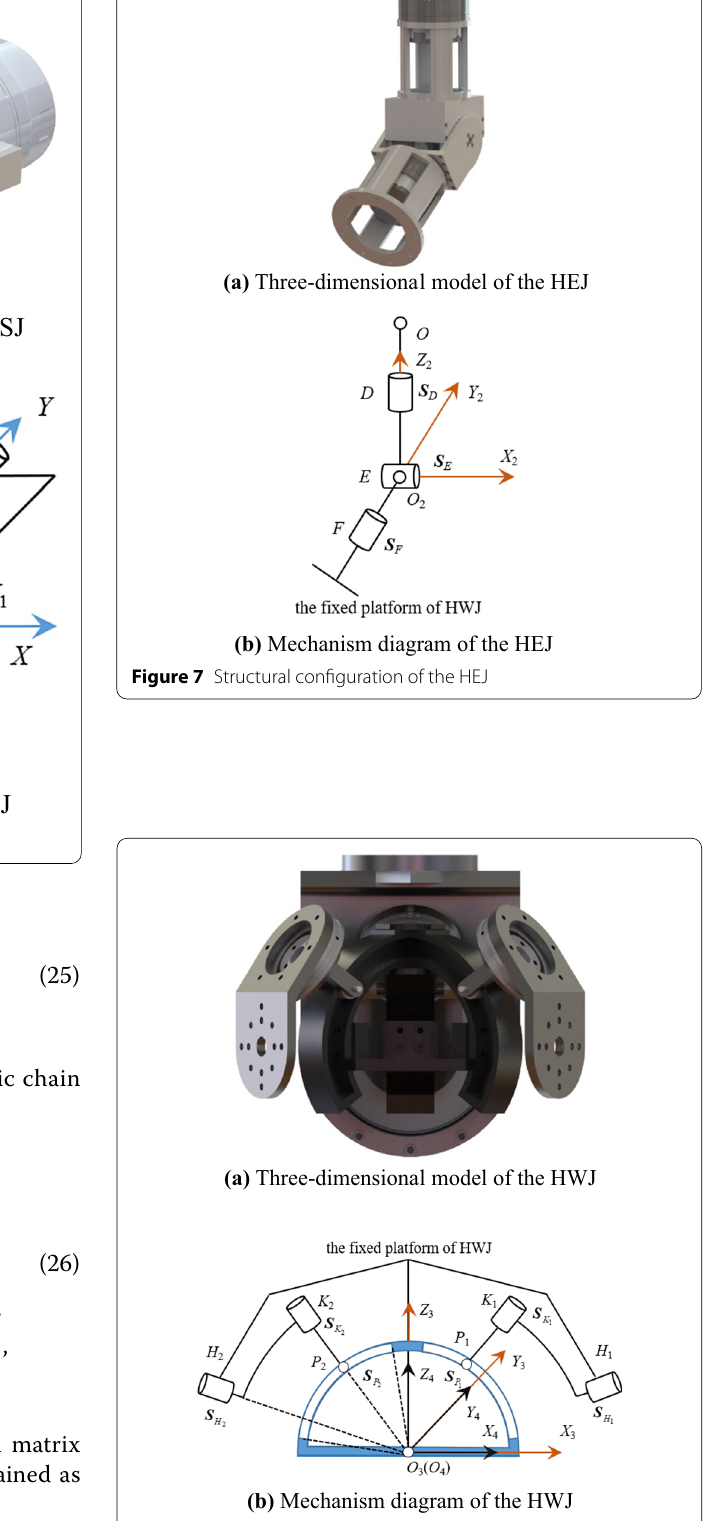
(b) Mechanism diagram of the HWJ Figure 8 Structural configuration of the